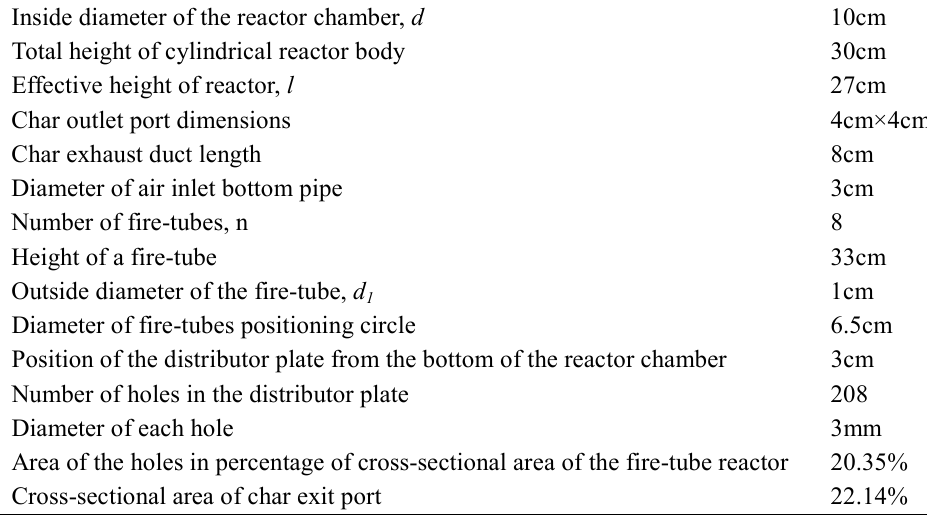
Fig. 1: Detail drawing of the cold model of a fire-tube reactor Table 1: Main geometric features of the cold model